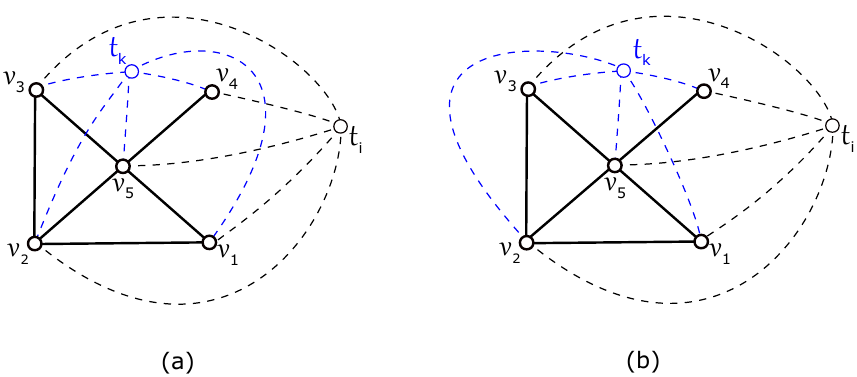
Figure 4. Two possible subdrawings of G 11 ∪ T i ∪ T k for T k ∈ S D with cr D ( T i , T k ) = 2, where T i ∈ R D with the configuration A 1 of F i . ( a ) The subdrawing in which the edge v 3 v 5 of G 11 is crossed by the edge t k v 2 ; ( b ) the subdrawing in which the edge v 4 v 5 of G 11 is crossed by the edge t k v 1 .